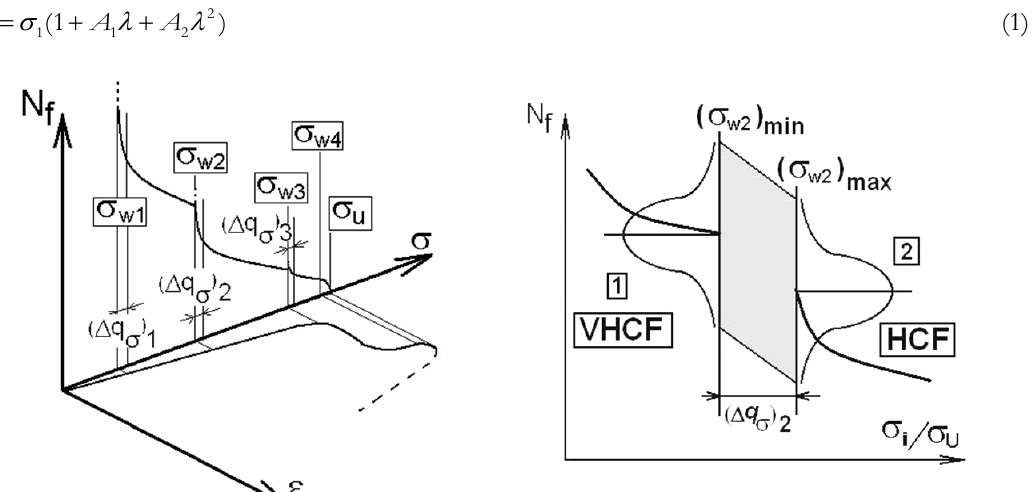
Figure 1: The bifurcation (a) diagram of metals fatigue has constructed according to the tension diagram and (b) schema of probability of metals cracking variation for the bifurcation area (  q  2 ). Bifurcation areas are specified at transitions from nano-(  w1 -  w2 ) to meso- (  w2 -  w3 ), and macro-(  w3 -  w4 ) scale level of metals